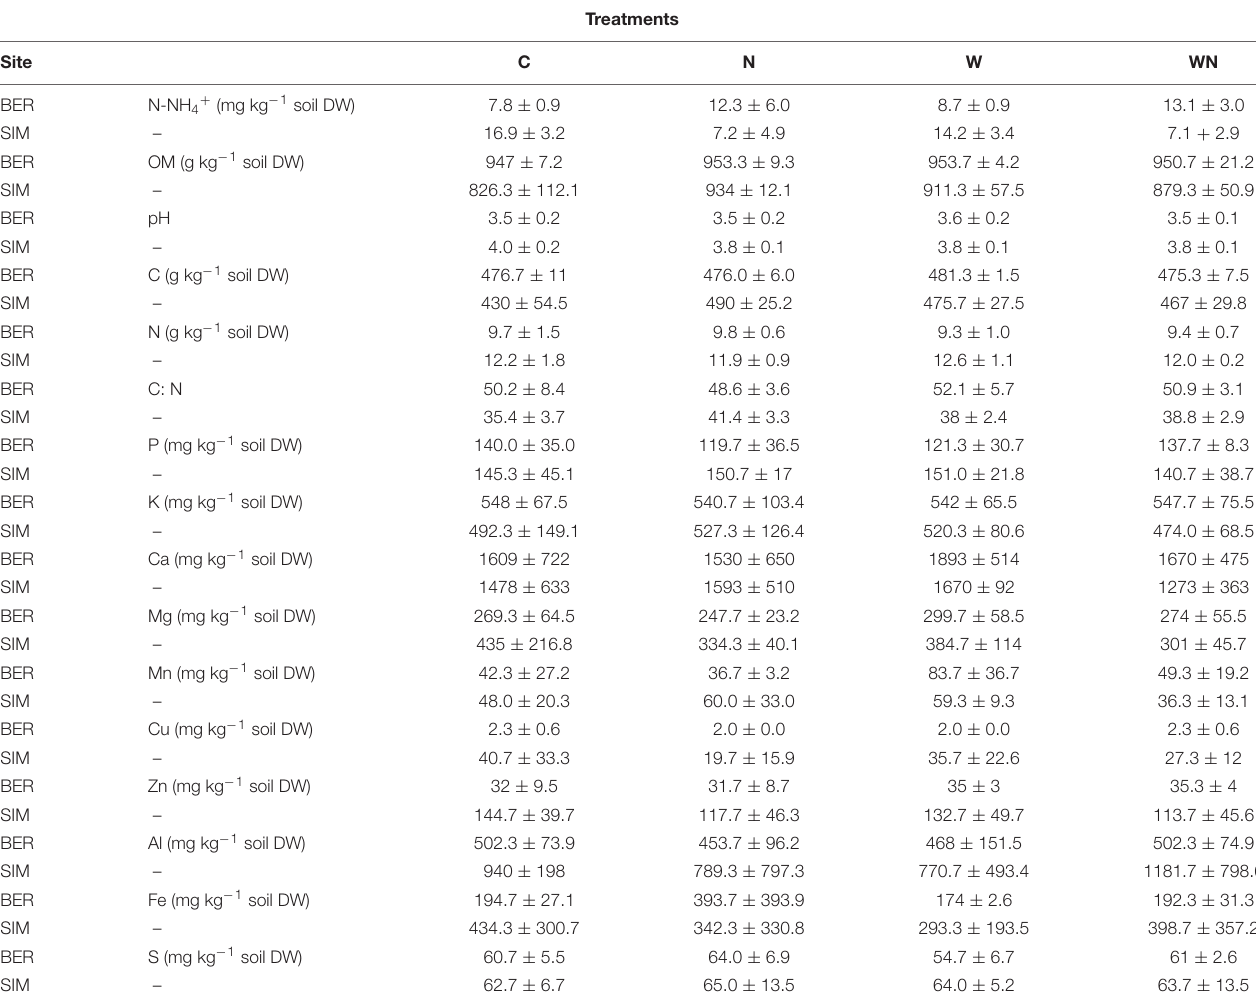
TABLE 1 | Forest floor chemical composition in the C (control), N (fertilized), W (warmed), and WN (warmed and fertilized) plots of both sites at the end of the 9-year experiment.